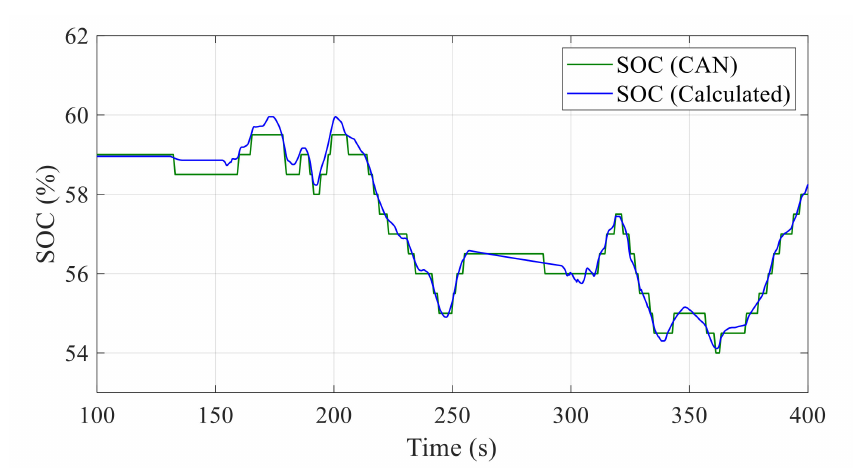
Figure 7. Comparing SOC Signal from CAN with SOC